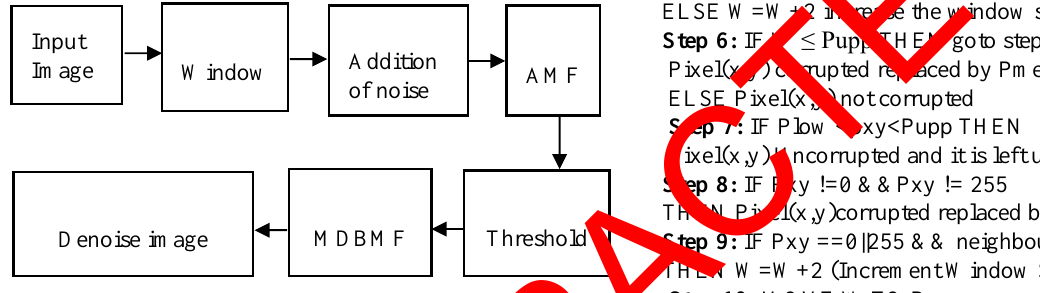
Figure 2. Proposed Efficient Denoising Algorithm